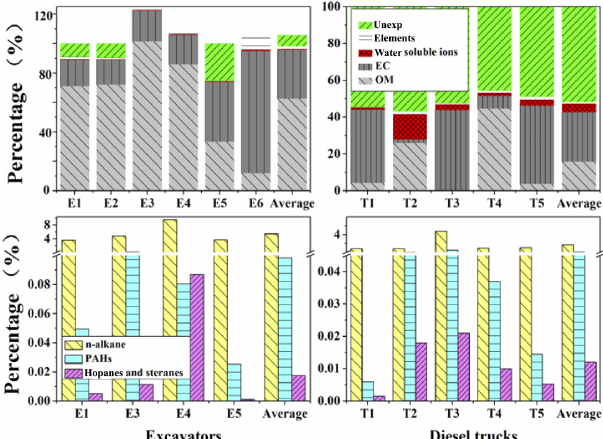
Figure 5. Compositional constituents of PM for individual vehi- cles